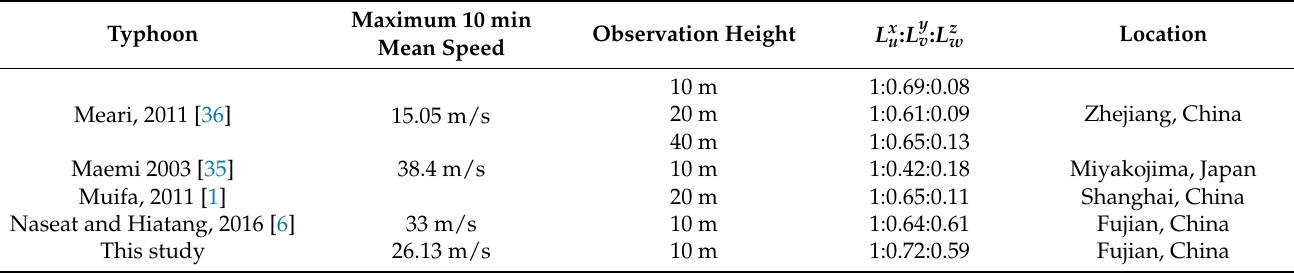
Figure 24. Integral length scale of the wind speed (10 m, 80 m, and 100 m). Table 7. Comparison of the integral length scale in the